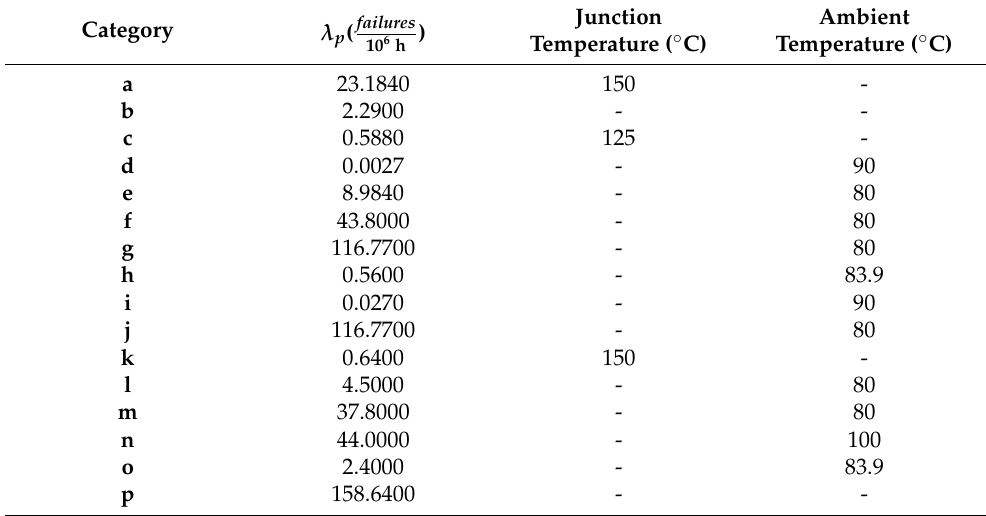
Table 4. Aging factors of PCB components and corresponding junction and ambient temperatures.